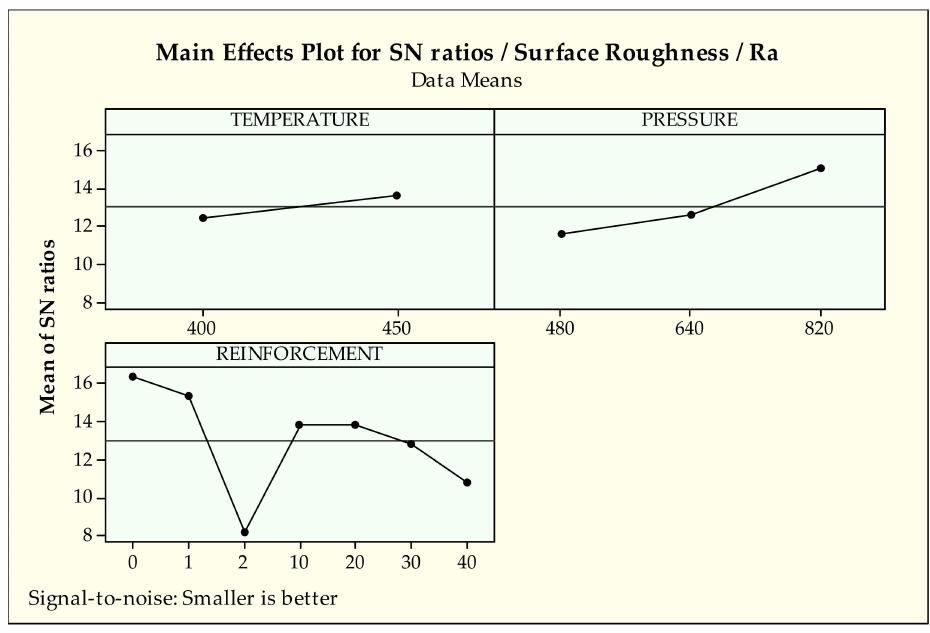
Figure 6. S/N ratios of surface roughness-Ra.